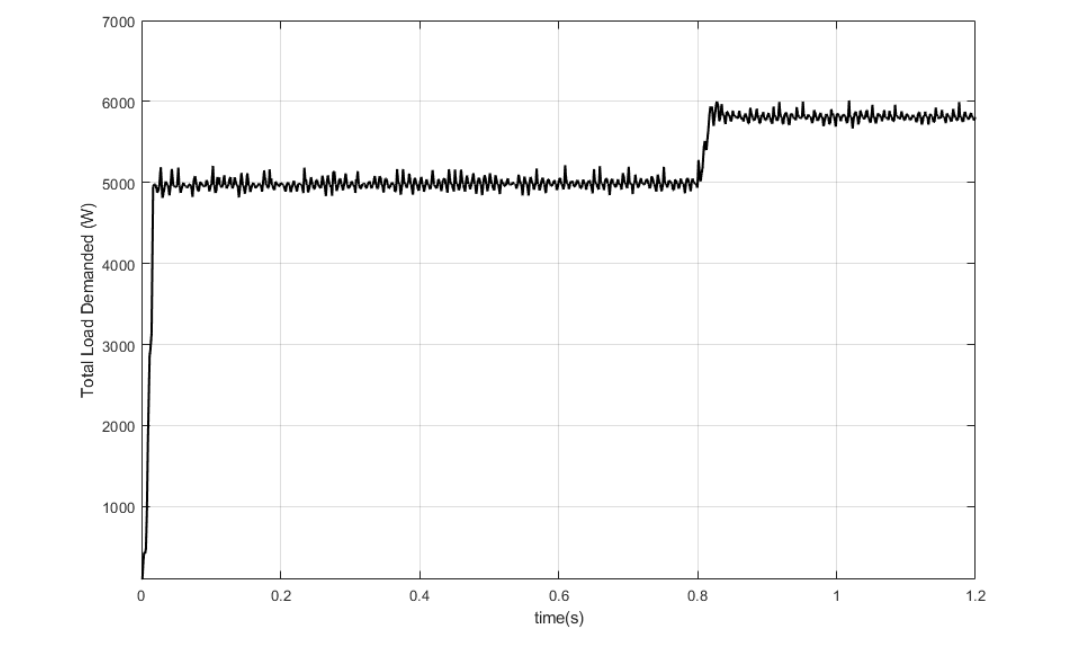
Figure 5. Total load demanded